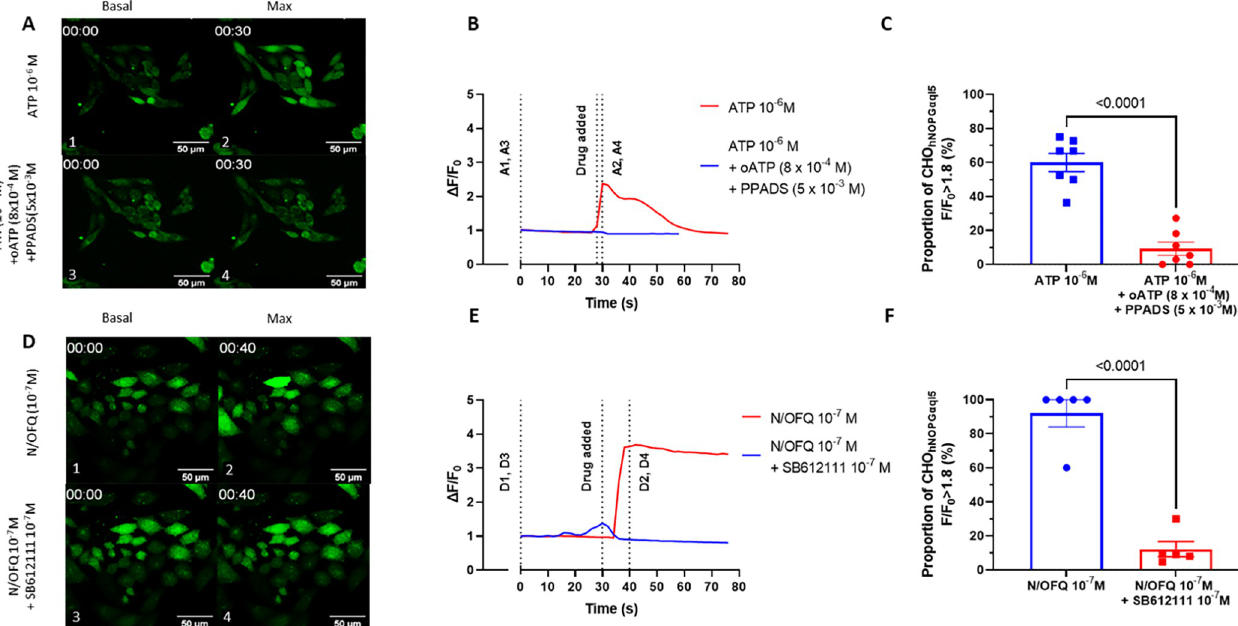
Fig 3. Response of CHO hNOPG α qi5 to ATP and N/OFQ in the presence and absence of antagonists. A . Representative change in Δ F/F 0 in response to exposure to 1x10 -6 M ATP in the absence (1, 2), and presence (3, 4) of the purinergic antagonists PPADS 5x10 -3 M and oATP 8 x10 -4 M as measured by confocal microscopy using FLUO-4 as an indicator dye. (basal 1, 3; maximal, 2, 4). B . Representative change in Δ F/F 0 in response to exposure to 1 x10 -6 M ATP as measured by confocal microscopy using FLUO-4 as an indicator dye in the presence and absence of PPADS and oATP in the concentrations stated. C . Combined cellular responses following exposure to 1 x10 6 M ATP in the presence and absence of PPADS and oATP in the concentrations stated. D . Representative change in Δ F/F 0 in response to exposure to 1 x10 -7 M N/OFQ in the absence (1, 2), and presence (3, 4) of the antagonist SB-612111 1 x10 -7 M as measured by confocal microscopy using FLUO-4 as an indicator dye. (basal 1, 3; maximal, 2, 4). E . Representative change in Δ F/F 0 in response to exposure to 1 x10 -7 M N/OFQ as measured by confocal microscopy using FLUO-4 as an indicator dye in the presence and absence of 1x10 -7 M SB-612,111. F . Combined cellular responses following exposure to 1 x10 -7 M N/OFQ in the presence and absence of 1x10 -7 M SB-612,111. Error bars where shown are SEM (n = 7), p values from unpaired